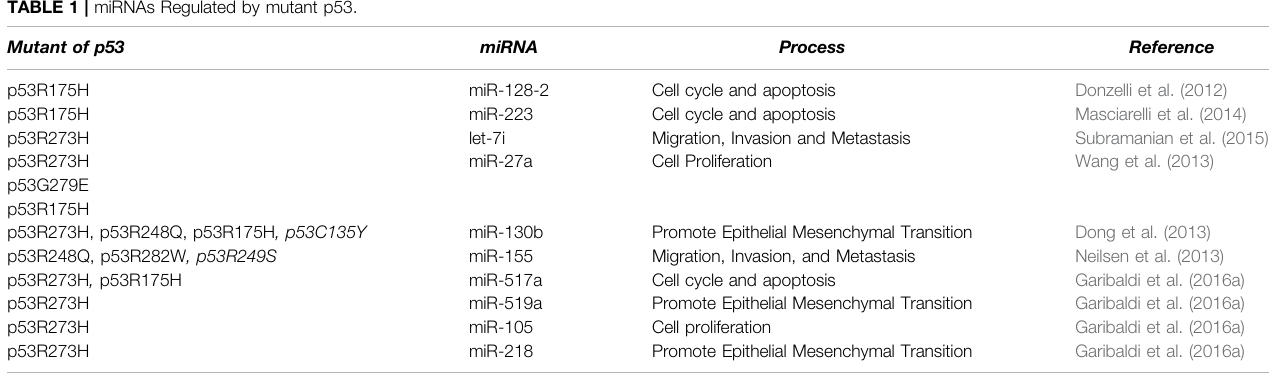
TABLE 1 | miRNAs Regulated by mutant p53.